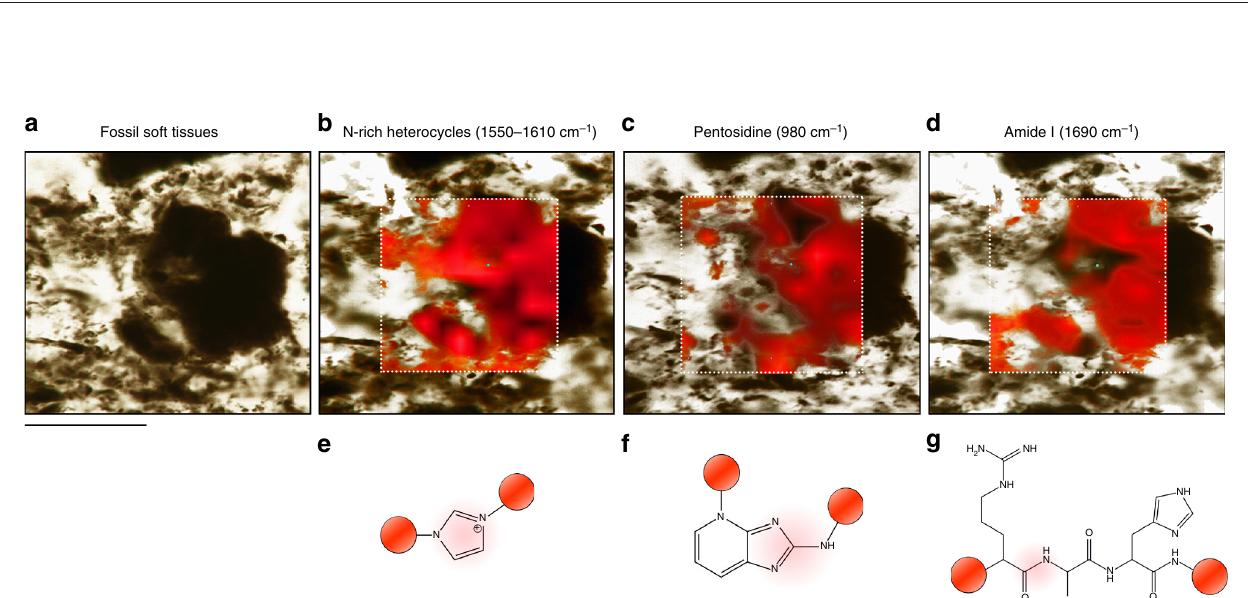
Fig. 2 Aligned Raman spectra of decalci fi ed modern, matured, and fossil organic material. All spectra were obtained in aqueous solution, 500 – 1800 cm − 1 , 20 s exposure time, 4 accumulations. These spectra are based on a total of 12 specimens with soft tissue preservation used for high-resolution point measurements, while Raman spectra for an additional 12 specimens without soft tissue preservation can be found in Supplementary Fig. 9; a total of additional 29 specimens was used for experimental maturation. a Teeth and enamel scales. b Bones. c Eggshells. Differences in the color of the sampled material are represented in the icons on the right. Brown spectral band: advanced glycoxidation and lipoxidation end products (AGEs), oxidative crosslinks; yellow spectral bands: peptide amides. AGE bands increase in intensity relative to amide I bands (dotted lines) with age and arti fi cial maturation. Protein degradation and deamidation over time are represented by a decrease in the band intensities identi fi ed as amide III and amide I. Details on experimentally matured reference tissues at different temperatures (autoxidation) on the right of the spectra show that oxidative, brown discoloration already occurs at low temperatures. The color scale associated with temperatures and incubation times for the maturation experiments range from red (relatively high temperatures) to blue (low temperatures). The scale bar equals 500 μ